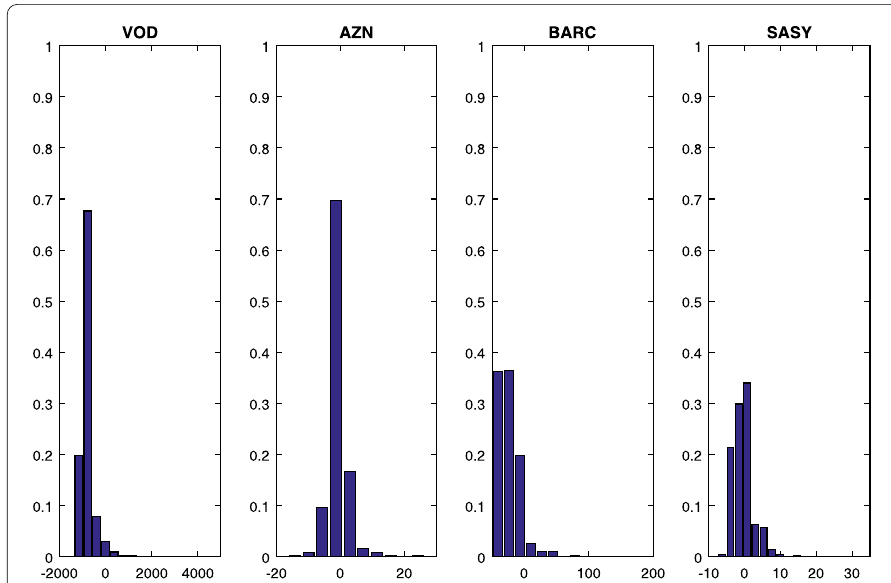
Figure 5 Retaliative frequency histogram of Negative Selection